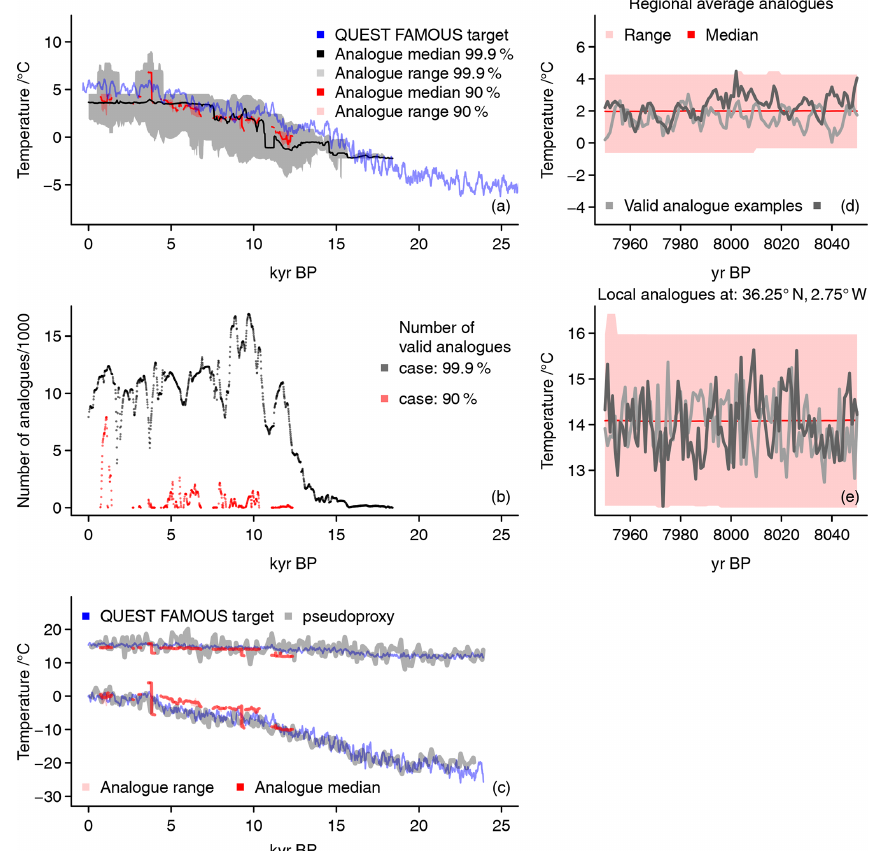
Figure 6. Reconstruction results for the pseudo-proxy application of the analogue method: (a) regional averages for 101-year moving averages for two different tolerance envelope levels (90%, reds, 99.9%, grey). Lines show the 101-year moving average regional target in the TraCE-21ka simulation (blue), the median of all analogues (90%, red, 99.9%, black), and the range of all analogues for the respective tolerance ranges (colored shading). Panel (b) shows the number of analogues found for each of the dates considered for both setups (90%, red, 99.9%, black). Panel (c) adds 101-year moving averages of local pseudo-proxy data (grey), local target data (blue), the range of all local analogue values (light red), and the local median of the analogues (red) for two locations (warmer case: 36.25 ◦ N, 2.75 ◦ W; colder case: 57.75 ◦ N, 8.75 ◦ E) and for the 90% tolerance envelopes only. Panels (d) and (e) provide expansions of regional (d) and local (e) 101-year moving average analogues into 101-year long time series for the 90% tolerance envelopes only. The panels show the median (red), the range (light red), and two valid analogue examples of the expansions. Due to the coarse resolution for the QUEST FAMOUS data, panels (c) and (e) use the remapped data of the